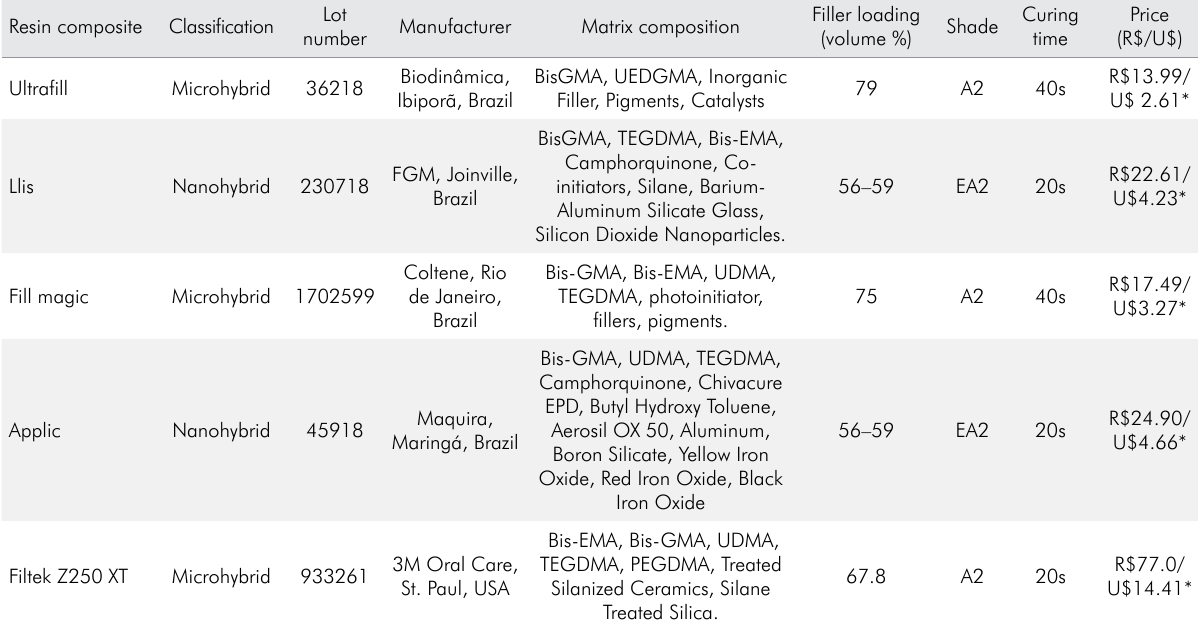
Table 1. Materials specifications as reported by the